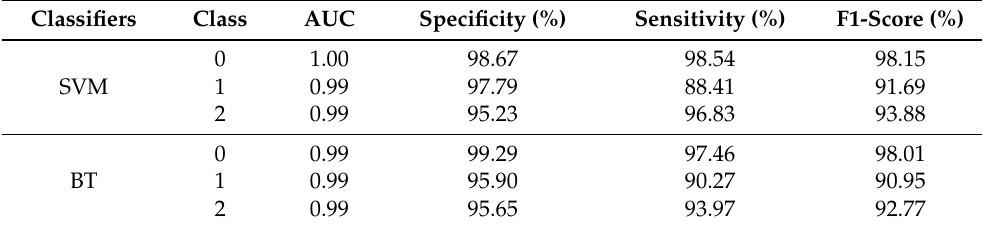
Table 3. Relative performance evaluation of the SVM and BT classifiers on the three classes, with cross-domain